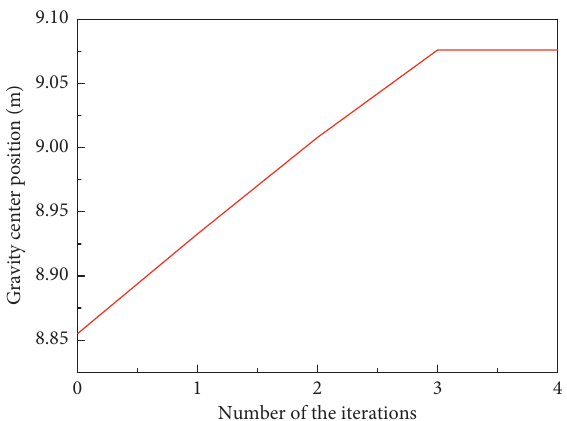
Figure 4: The iterative results of the center of gravity of a semisubmersible platform (Case 3) in still water.